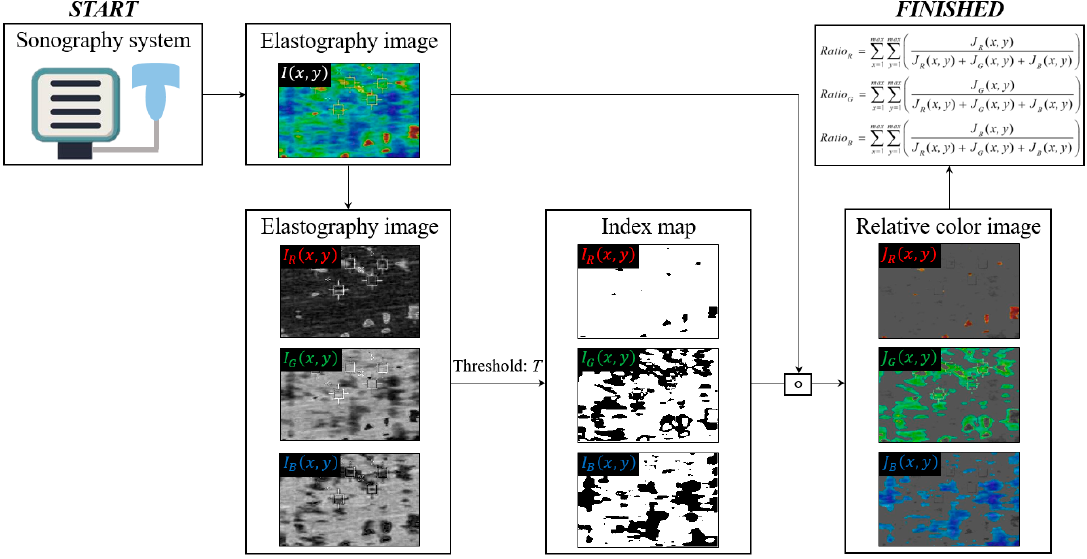
Figure 2. Simplified illustration of proposed stiffness measurement process using a shear wave elastography image.